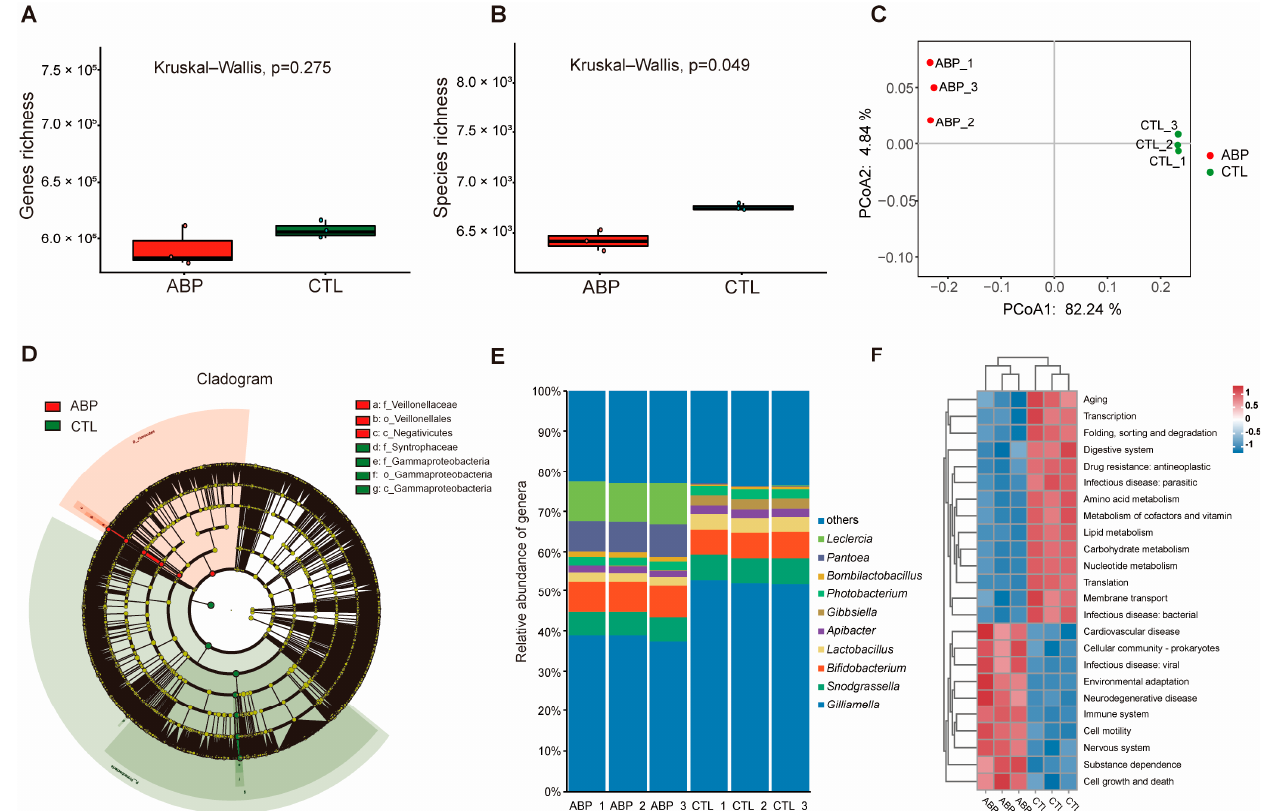
Figure 4. Effects of ternary mixed fungicide of ABP (azoxystrobin: boscalid: pyraclostrobin = 1:1:1, m/m/m) on gut microbial communities and function of A. cerana cerana . Comparison of the ( A ) gene richness and ( B ) species richness between fungicide exposure and CTL group. Each group includes three experimental repeats. ( C ) Principal coordinate analysis (PCoA) shows beta diversity among gut microbiota of fungicide exposure and CTL group based on Bray–Curtis distance. ( D ) Taxon differences in the gut microbiota between ABP and control group. Sizes of each dot is proportional to taxon abundance. Red-shaded areas indicate ABP-enriched taxa; green-shaded areas indicate the CTL-enriched taxa. Only the taxa that meet a significant LDA threshold value of >3 are shown. ( E ) Stacked bar plot of relative abundances of main bacteria at the genus level for each sample. ( F ) Hierarchical clustering heatmap of KEGG functional pathways from all samples. An increasing relative abundance is indicated by a color gradient from blue to